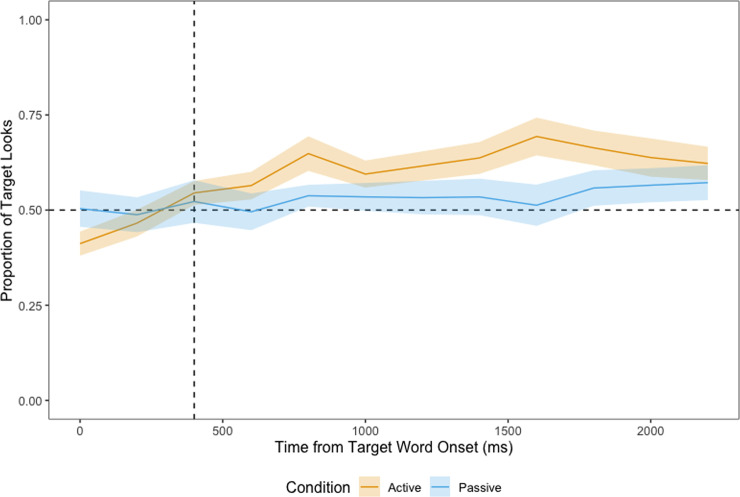
Proportion of looks at the target in 2-AFC trials, time-locked to the onset of the target word.Dashed vertical line at 400 ms marks the beginning of the analysis window, dashed horizontal line represents chance (0.5).